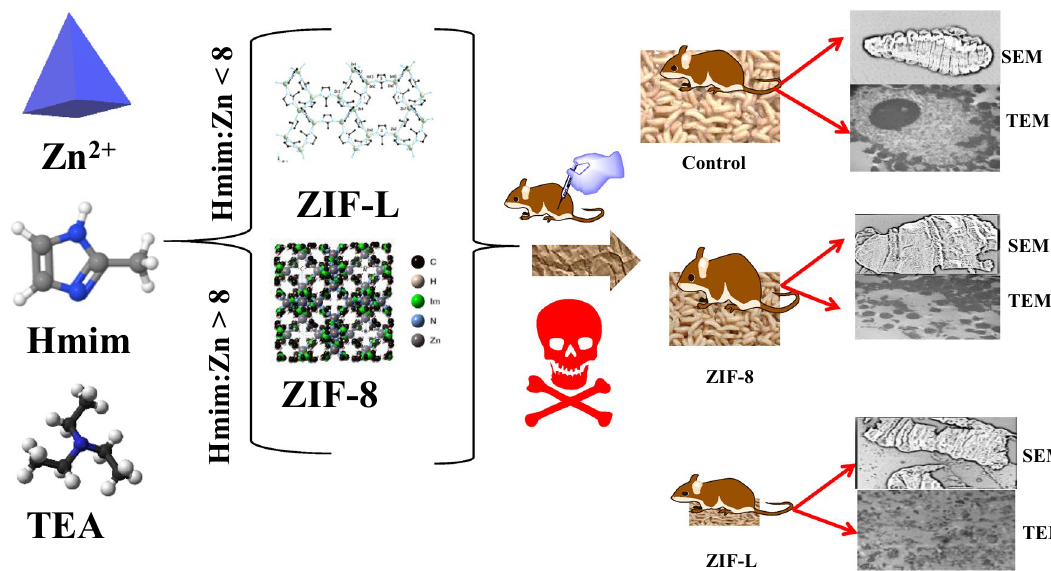
Figure 1. Synthesis of ZIF-8 and ZIF-L and their applications for